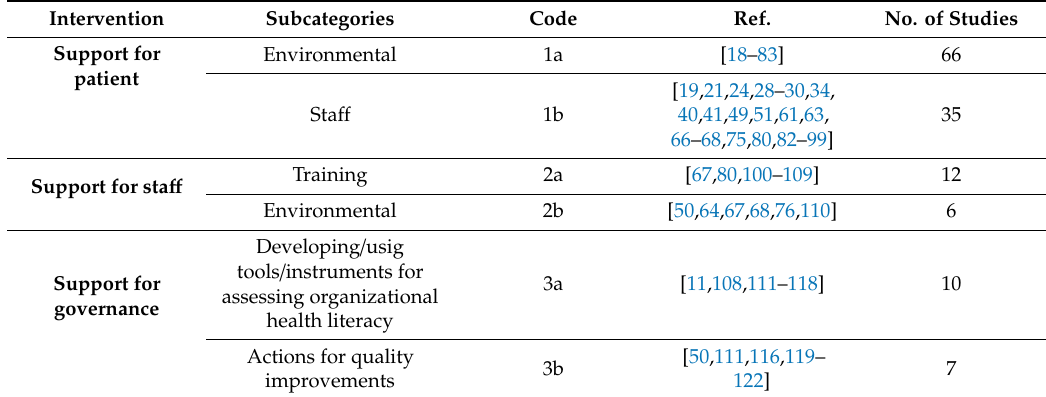
Table 3. Interventions (see supplementary file for more detail).